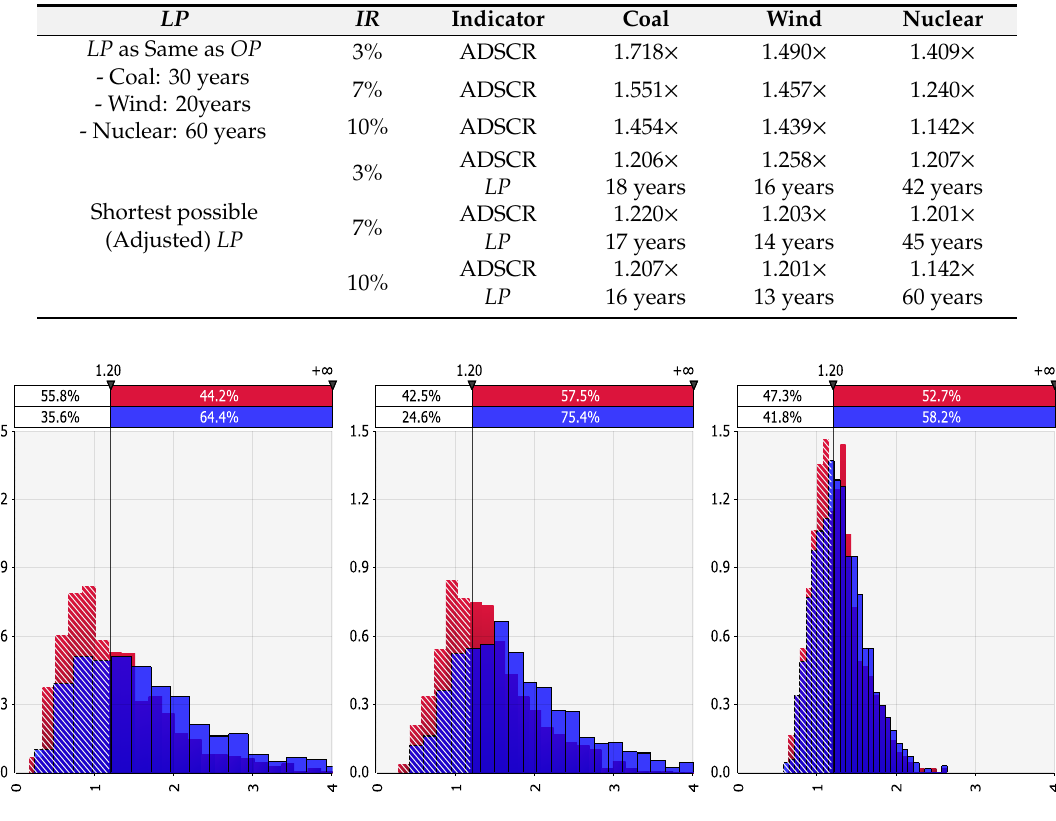
Figure 2. ADSCR distributions of Coal, Wind, and Nuclear during original and adjusted LP s at 7% IR. Table 6. ADSCR values of Coal, Wind, and Nuclear during original and adjusted LPs.